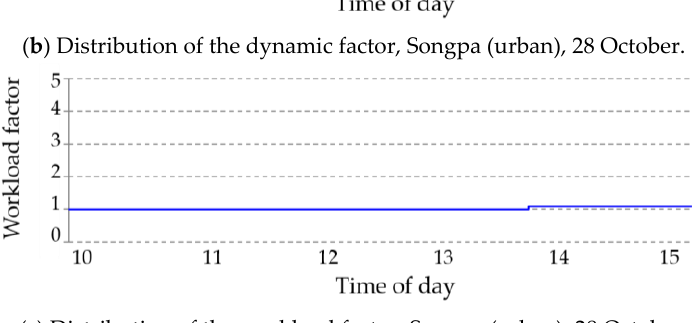
Figure 4. Distribution of the three factors of the SI, collected by a postal motorcyclist working in Songpa on 28